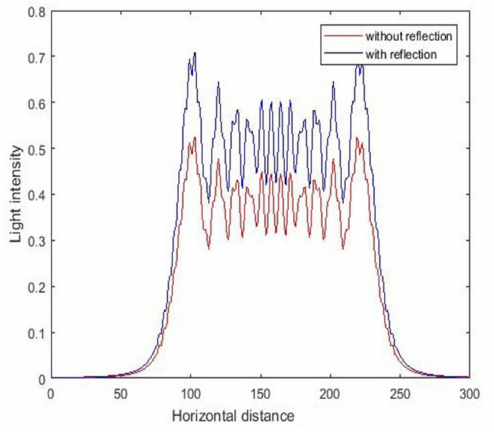
Figure 10. The intensity curve for vertical exposure at depth of 300 µ